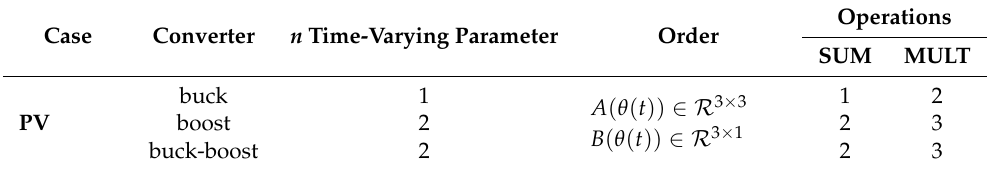
Table A1. Amount of operation to generate the control action online by K ( θ ( t )) controller parameters.